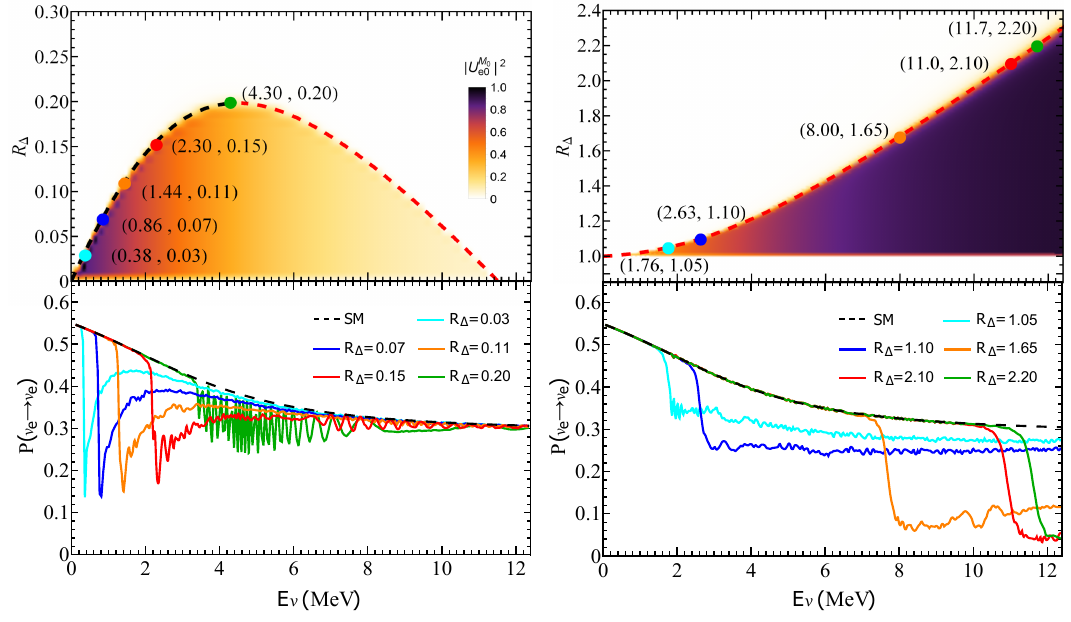
∆ . The black (red) dashed